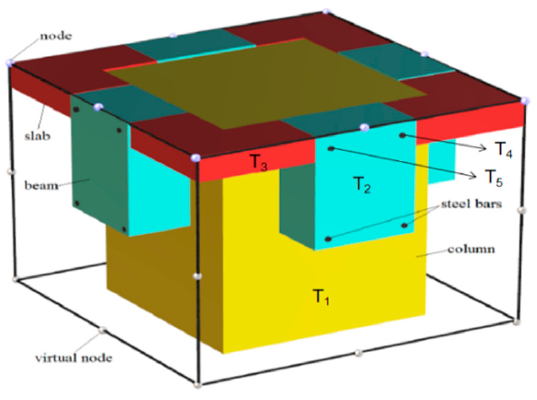
Figure 1. Block division of the element.